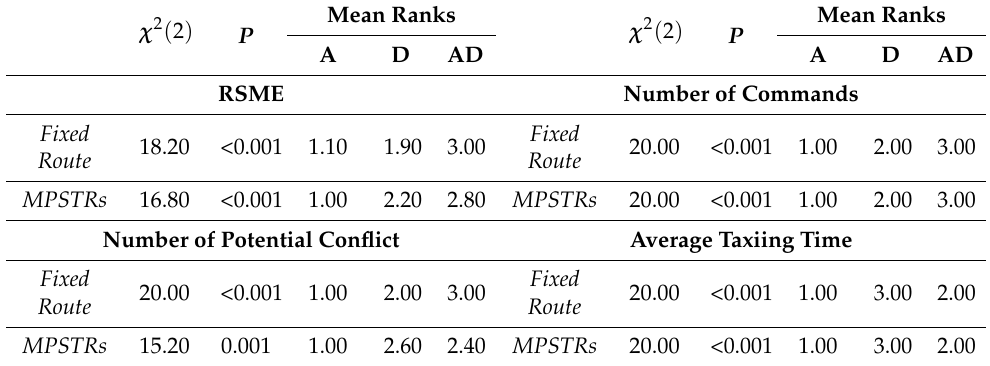
Table 4. Results of Friedman tests on control performance